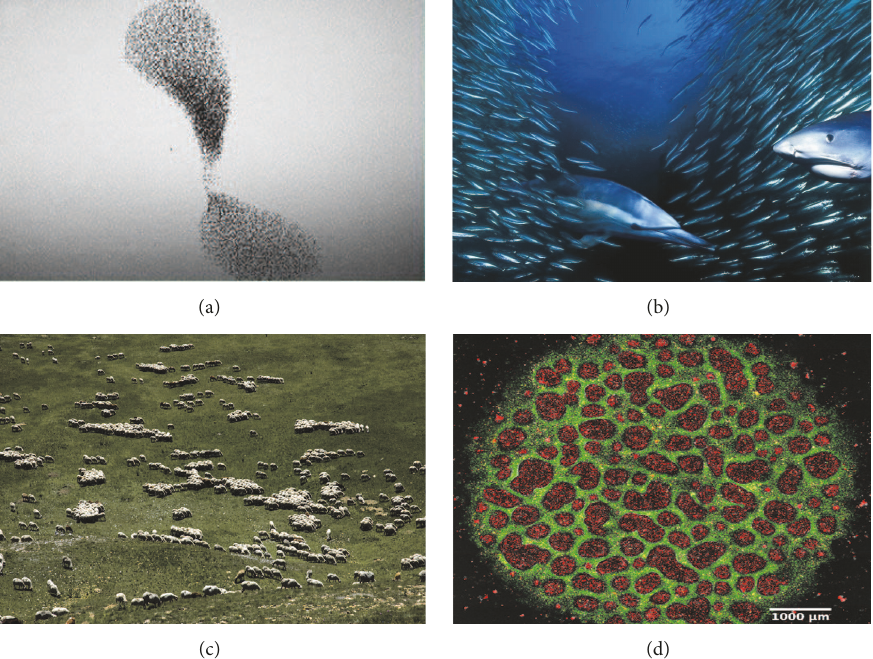
Figure 1: Typical fission-fusion behaviors of flocking system in nature. (a) European starlings, Sturnus vulgaris , over Rome [3]; (b) shoal of sardines, in Kwazulu-natal, South Africa; (c) Merinos d’Arles sheep, Ovis aries [6]; (d) segregation in mixed cocultures of primary goldfish keratocytes (PFK, red) and EPC fish keratocytes (EPC, green)